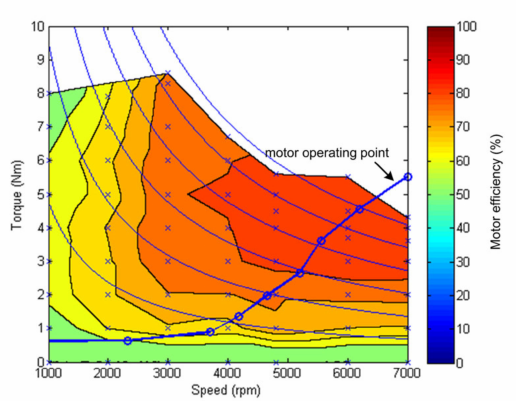
Figure 18. Efficiency map of the constructed three-phase 6/4 pole SRM.